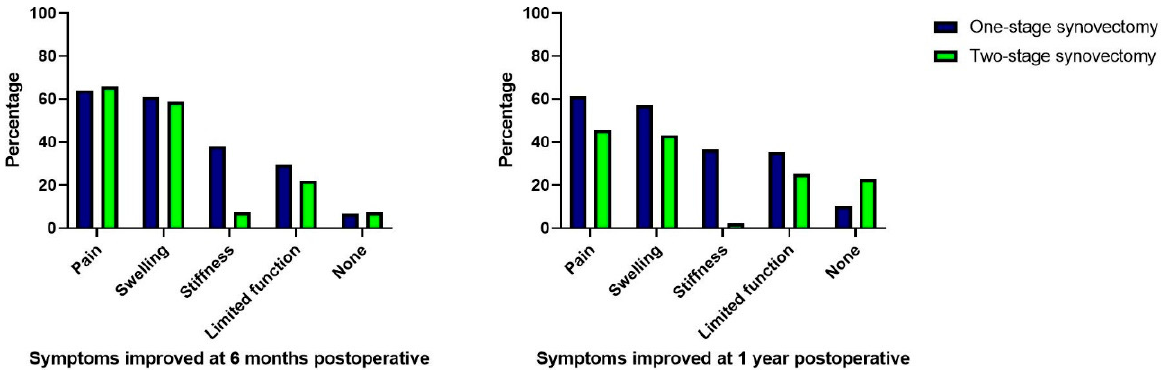
Figure 4. Symptoms improved at six months and one year postoperatively.